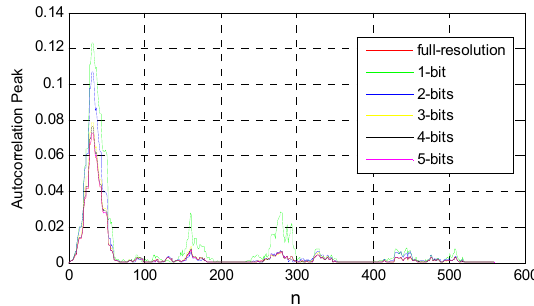
Figure 5. Autocorrelation curve at low resolution.